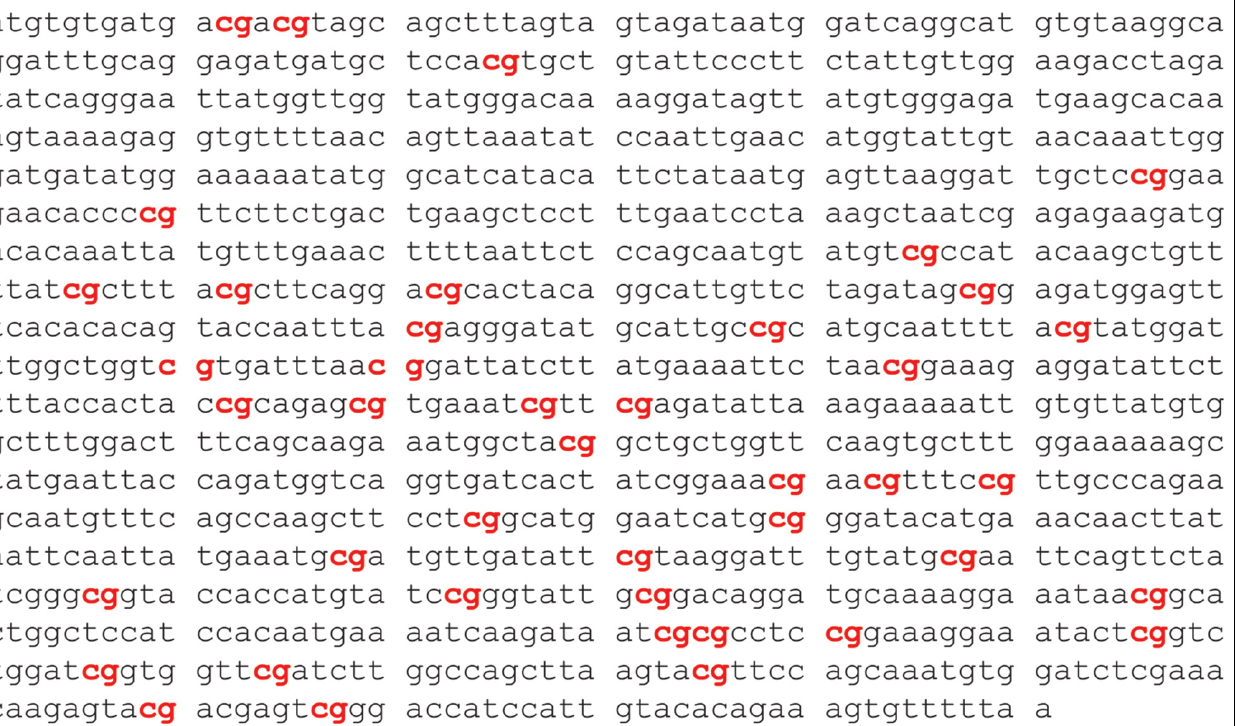
FIGURE 2 | Examples of high CG and low CG genes. (A) Apis mellifera Ubx has 97 CG s in the coding region of a 993 base pair cDNA.The 5mC level of high CG -content genes, such as Ubx, is low. (B) A. mellifera actin has 40 CG s in the coding region of a 1131 base pair cDNA.The 5mC level of low CG -content genes, such as actin, is